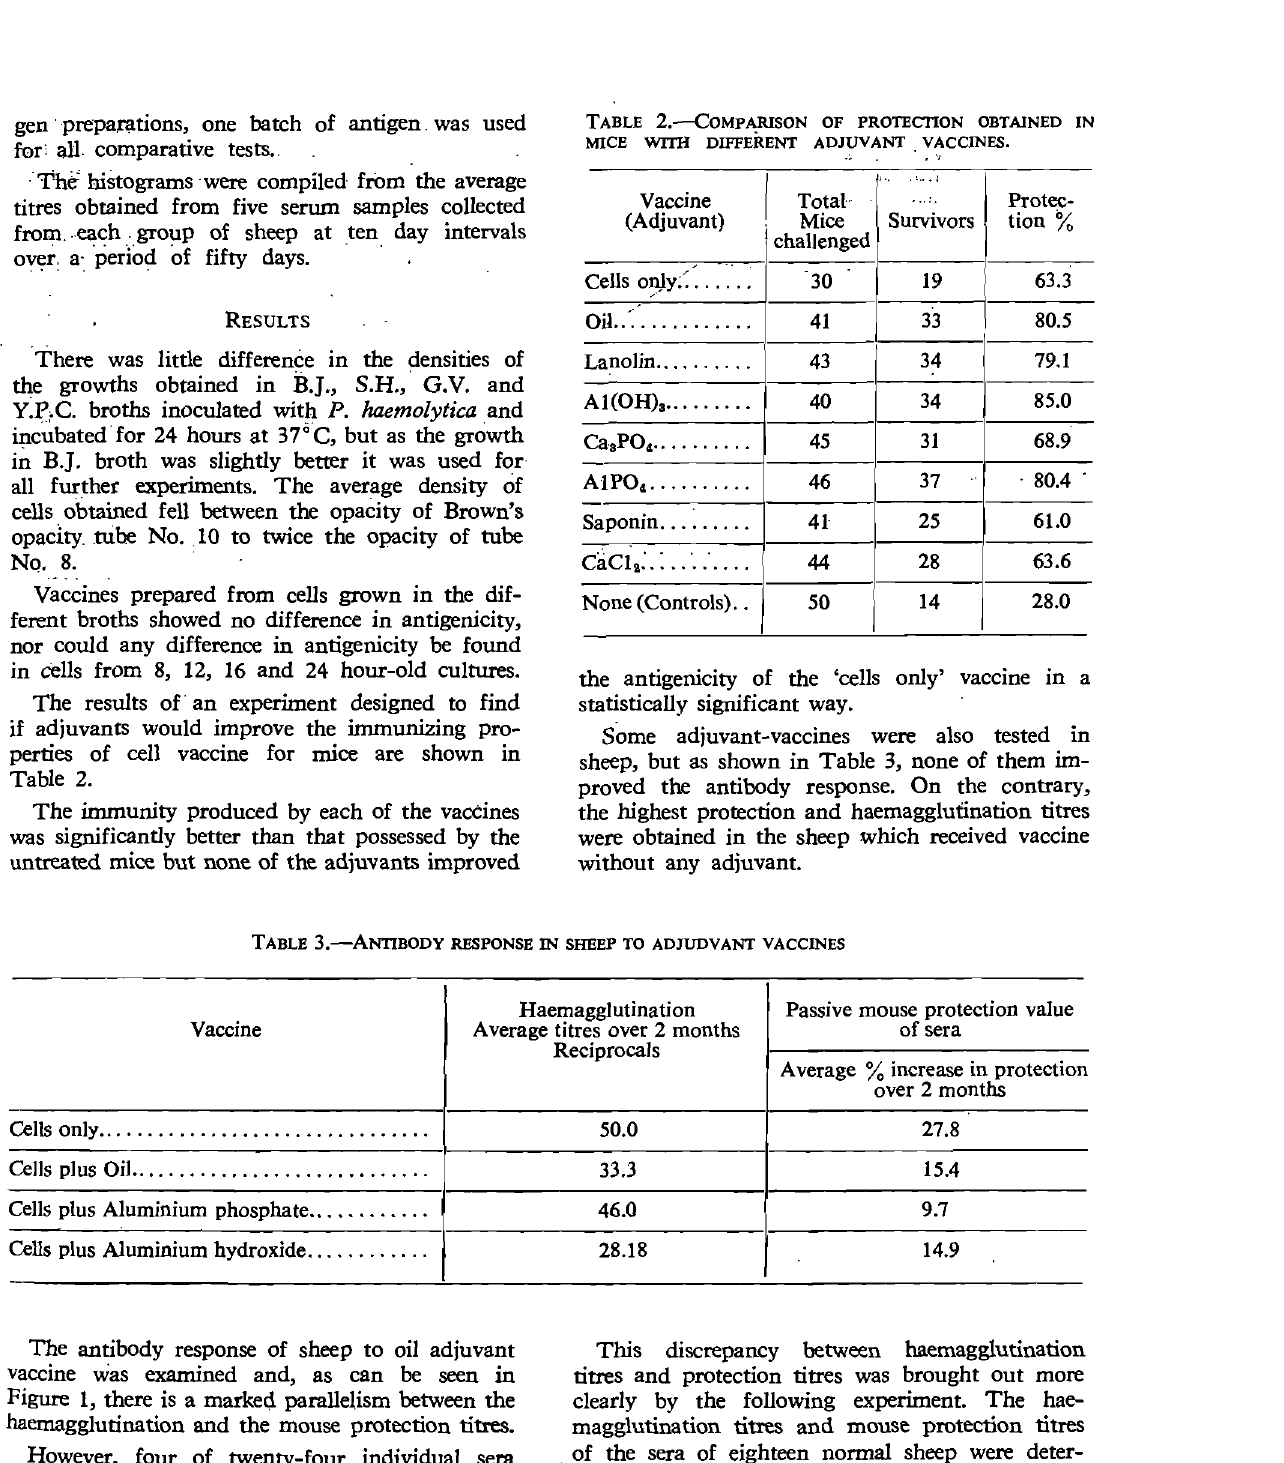
Figure 2; there is no· correlation between hae- magglutination arid mouse protection